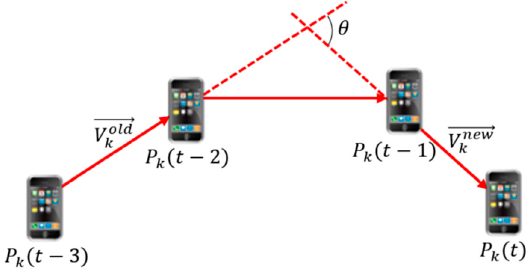
Figure 2. An example of a user’s moving process.